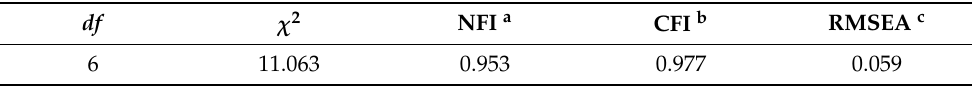
Table 3. Fit index of the proposed model.